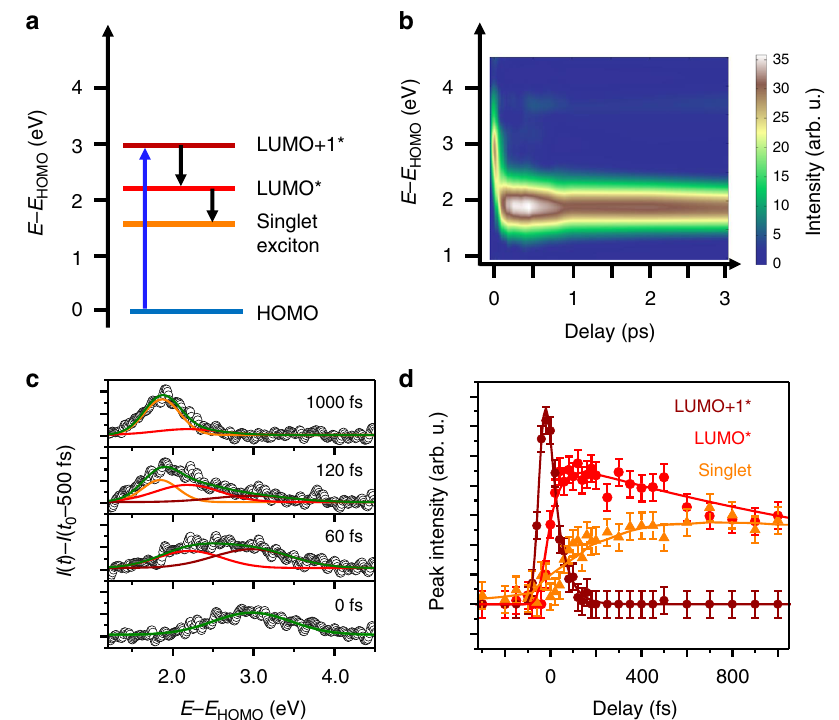
Fig. 2 Quasi-particle dynamics of excited excitons in C 60 /Ag(111) (10 ML, F = 40 ± 12 µ J cm − 2 ). a Single particle energy level diagram of the optical quasiparticle states of a C 60 molecular crystal. The electronic transition induced by the optical excitation is marked with a blue arrow, the subsequent decay steps by black arrows. b Two-dimensional E − E HOMO ( t ) spectrum of the quasiparticle dynamics in the unoccupied states recorded by time-resolved photoemission spectroscopy (tr-PES). Selected energy distribution curves (EDCs) at characteristic time delays are shown in panel c . The transient changes in the spectral density can be described by a fi tting model considering three excitonic states: the second to lowest unoccupied molecular orbital exciton (LUMO + 1*) ( E − E HOMO = 3.0 eV), the LUMO* exciton ( E − E HOMO = 2.2 eV), and the singlet exciton ( E − E HOMO = 1.9 eV). In our experiment, the linewidth of all excited state signals is determined by the time-independent inhomogeneous broadening of the experiment, i.e., by the structural inhomogeneity of the C 60 fi lm as well as by the spectral bandwidth of our laser light source. d Temporal intensity evolution of the three excited states shown as brown, red, and orange data points for the LUMO + 1*, the LUMO*, and the singlet state. The error bars represent the uncertainty of the fi tting parameter in the fi tting routine used to analyze the excited state spectra in c . The characteristic timescales of the exciton formation and decay are obtained by a dedicated fi tting model (solid